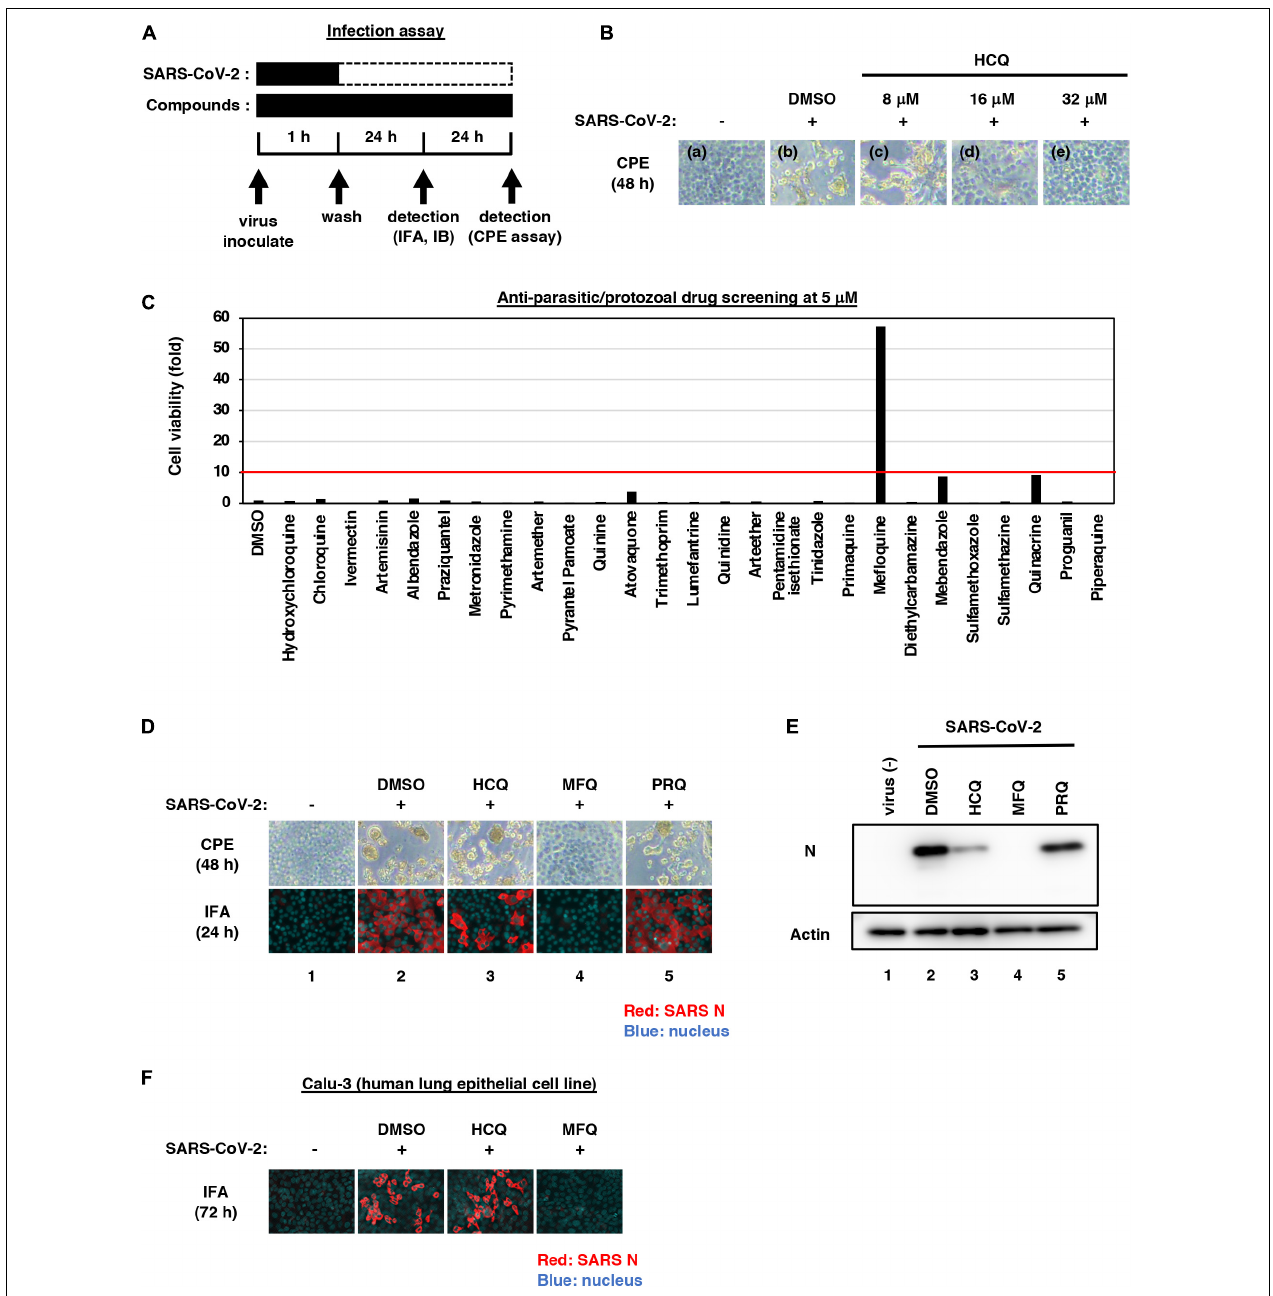
FIGURE 1 | Mefloquine (MFQ) inhibits Severe Acute Respiratory Syndrome-related coronavirus 2 (SARS-CoV-2) propagation. (A) Schematic representation of the SARS-CoV-2 infection assay. VeroE6/TMPRSS2 cells were inoculated with SARS-CoV-2 (Wk-521 strain) at an MOI of 0.001 for 1 h. After removing the unbound virus, cells were cultured for 24 h to detect virus-encoding N protein by immunofluorescence assay (IFA) and immunoblot (IB) or to detect viral RNA in the culture supernatant by RT-qPCR, or for 48 h to observe virus-induced cytopathic effect (CPE). Compounds were treated given throughout the assay. (B) Dose dependency of Hydroxychloroquine (HCQ) on CPE suppression. VeroE6/TMPRSS2 cells were inoculated with the virus for 1 h. Removing the unbound virus, cells were cultured with a medium containing the indicated compounds for 48 h. CPE was observed by microscopy. (C) Screening of anti-parasitic/protozoal drugs in the cell-based infection assay. Compounds were administrated at 5 µ M, at which hydroxychloroquine showed little effect on CPE. The viability of infected cells was quantified via a high content imaging analyzer by setting the value for the sample treated with DMSO solvent as 1. MFQ showed more than 57-fold higher cell viability than DMSO controls. (D,E) SARS-CoV-2-induced CPE and viral N protein expression upon compound treatments [DMSO at 0.08%; hydroxychloroquine (HCQ), mefloquine (MFQ), and primaquine (PRQ) at 8 µ M]. Red and blue signals of merged images indicate viral N protein and nucleus, respectively ( D , lower). Viral N protein and actin, an internal control, were detected by immunoblot (E) . (F) The anti-SARS-CoV-2 activity of the indicated compounds in Calu-3 cells, a human lung epithelial cell-derived line.